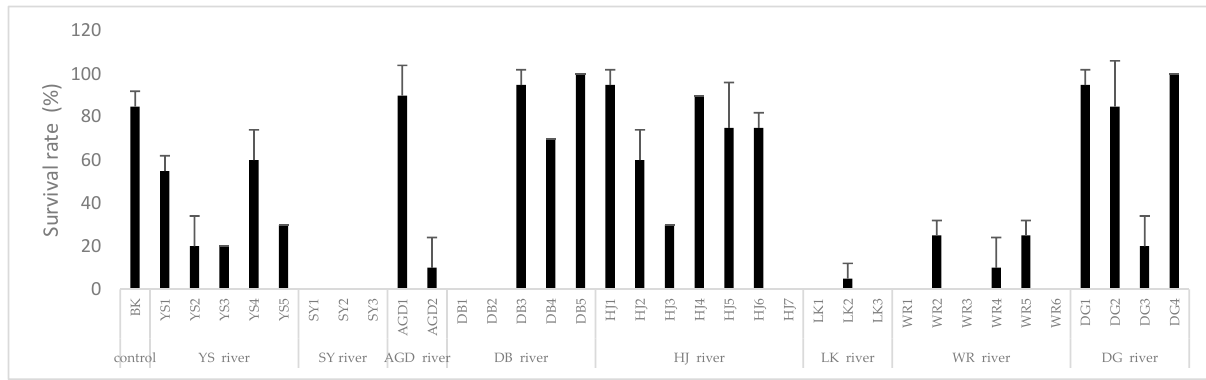
Figure 2. Survival rate of Hyalella azteca exposed to 35 sediment porewater samples in eight river basins. Error bars represent standard deviations (n = 2).